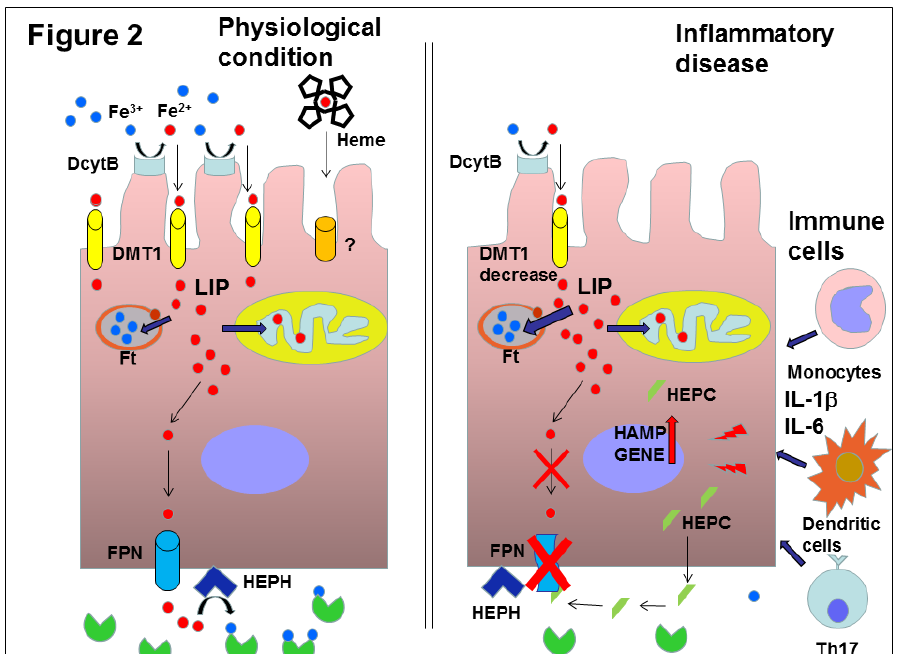
Figure 2. In physiological conditions, DcytB reduces the intestinal iron from Fe 3+ to Fe 2+ that can enter the enterocytes by means of DMT1. Iron, complexed in the heme group, is absorbed through an as yet unknown transporter. Iron enters in the enterocyte and constitutes the labile iron pool (LIP) that reaches the basolateral membrane to be released in the blood circulation by ferroportin (FPN). Iron is then oxidized to Fe 3+ by hephestin (HEPH) and is bound and transported by transferrin (TF) circulating in the blood to satisfy body need. Under inflammation, hepcidin (HEPC) expression is upregulated through cytokines produced by IELs, such as interleukine-6 (IL-6) and interleukine-1beta (IL-1 β ). In enterocytes, the expression of HEPC could play a role in local iron homeostasis regulation, in an autocrine/paracrine manner. HEPC might induce FPN degradation or inactivation, decreasing iron efflux. The consequent increase of cellular iron might determine the diminution of DMT1 expression to decrease iron absorption. Therefore, this mechanism, caused by local inflammation, might exacerbate defective iron absorption due to reduced absorptive surface area in the intestine of patients presenting with anemia.